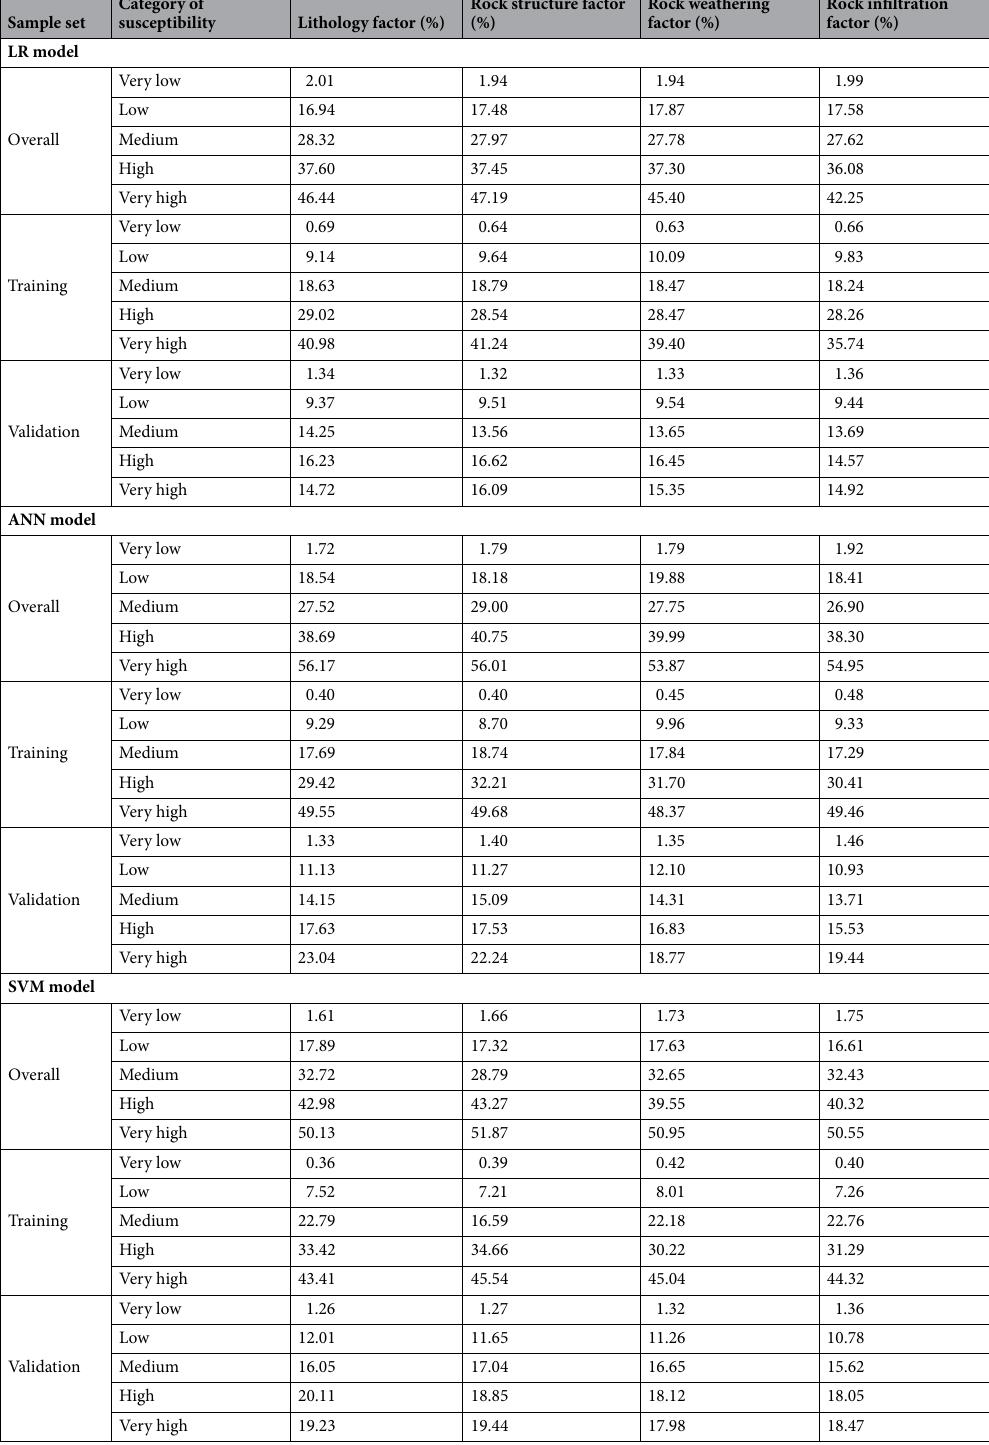
Table 7. Specific category precision